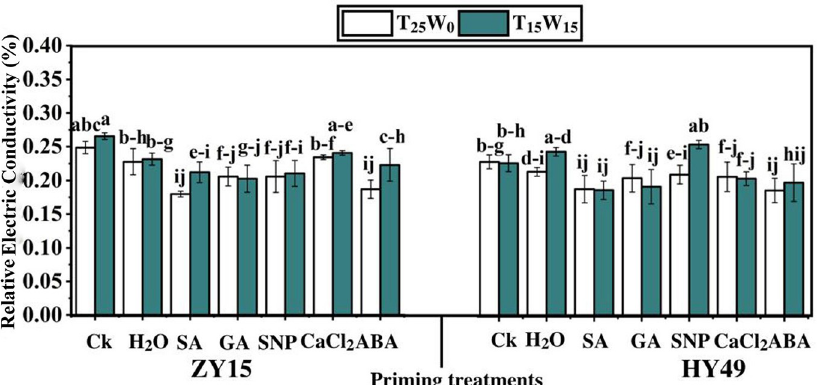
Fig 2. Effects of low temperature and drought stresses (25˚C and 0 MPa, 15˚C and -0.15 MPa) on the relative electrical conductivity (%) of Brassica napus seedlings (varieties ZY15 and HY49). Seven different treatments ( a ) control (Ck), ( b ) water (H 2 O), ( c ) salicylic acid (SA), ( d ) gibberellic acid (GA), ( e ) sodium nitroprusside (SNP), ( f ) calcium chloride